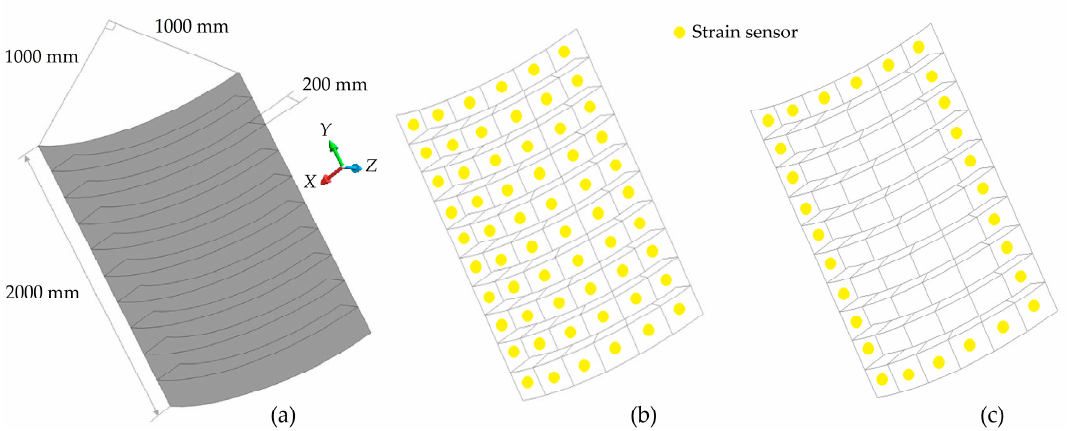
Figure 12. ( a ) Dimensions of the stiffened curved plate; ( b ) sparse and ( c ) very sparse sensor placement models.